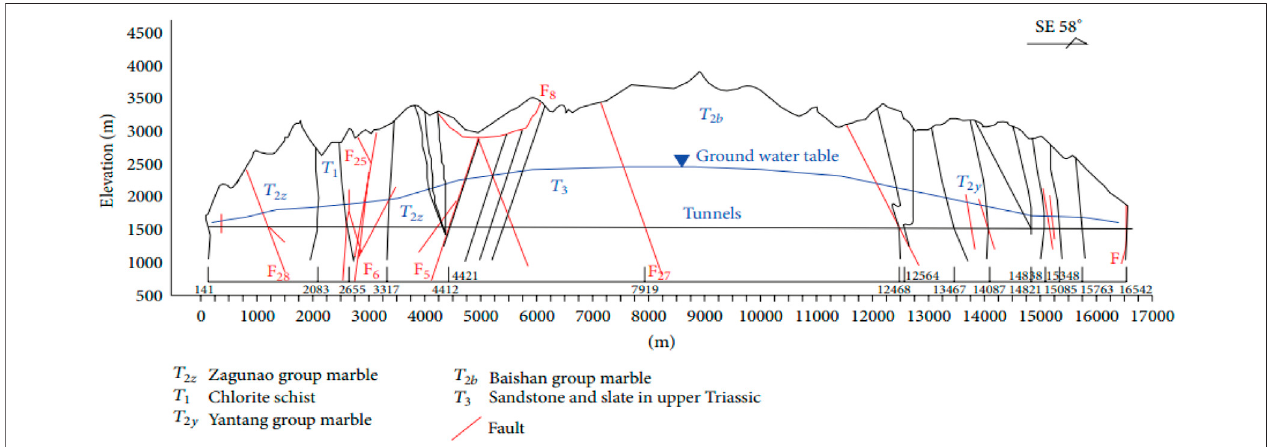
FIGURE 2 | An engineering geological pro fi le of deep-buried tunnel of Jinping II Hydropower Station.